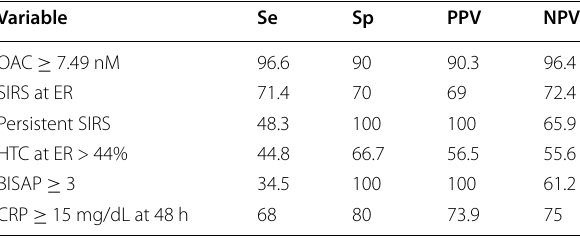
Table 3 Prognostic accuracy of OAC for moderately severe-to-severe disease compared to other widely used predictors